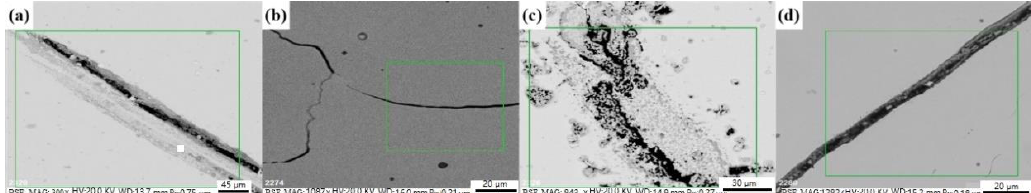
Figure 11. SEM images of the microcrack zone produced on the interior of the samples with the strain of 0.5 at different temperatures. ( a ) 1050 °C, ( b ) 1100 °C, ( c ) 1150 °C, ( d ) 1200 °C.